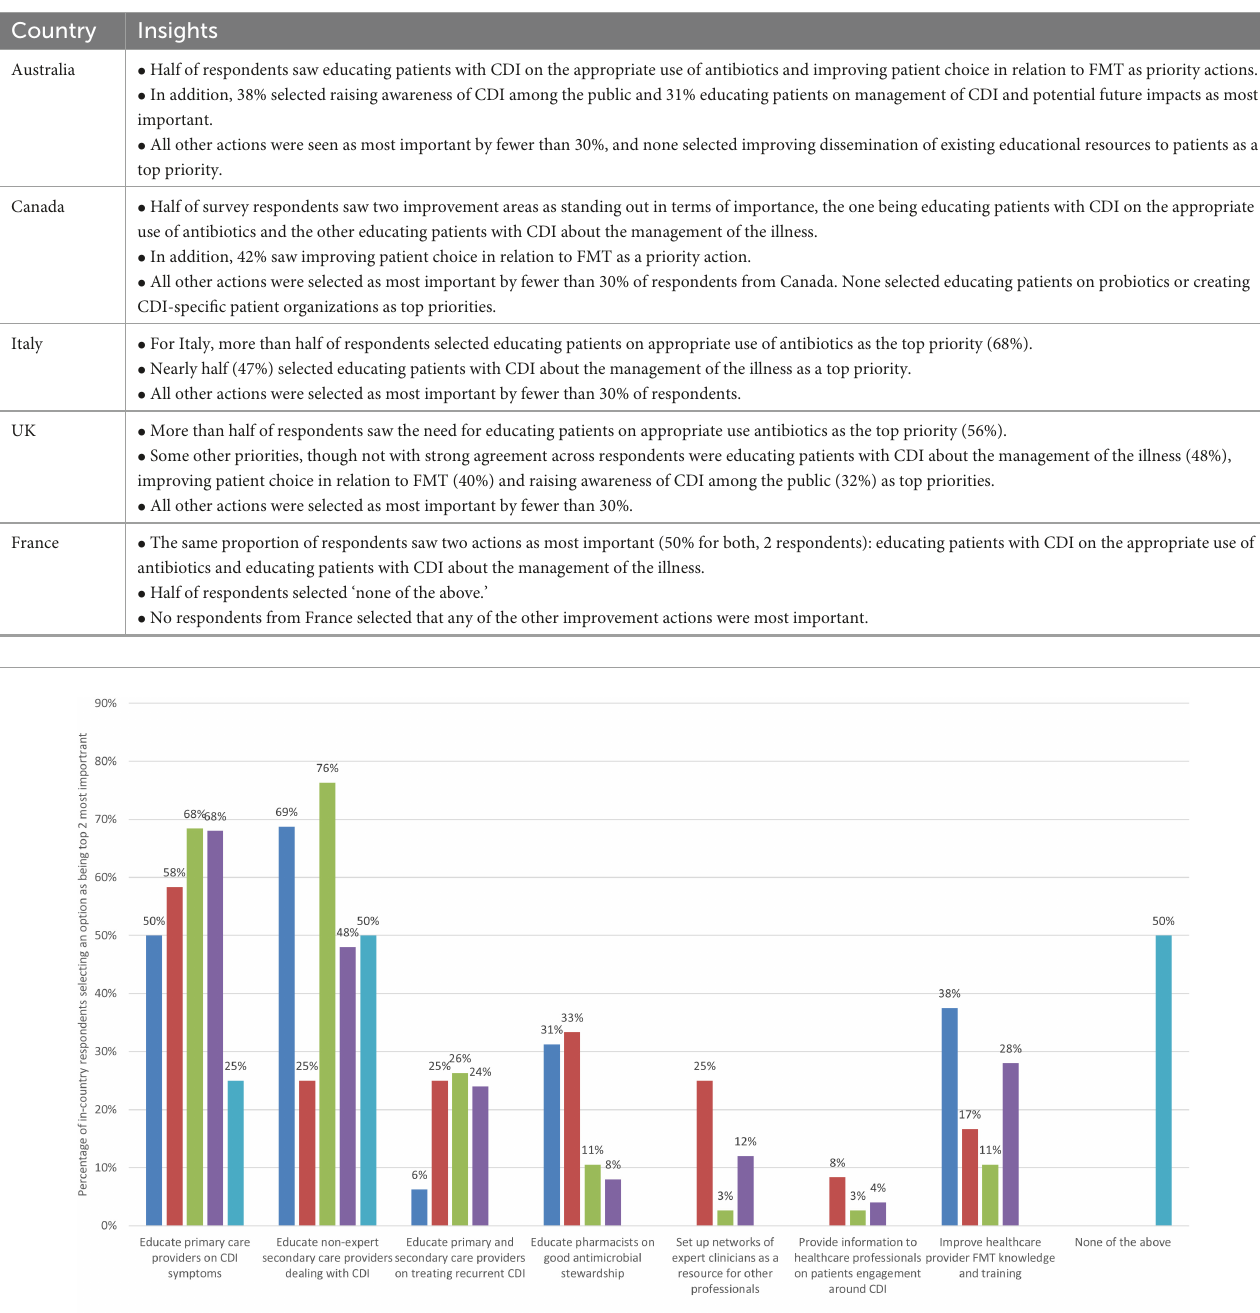
TABLE 7 Country-level insights relating to education and awareness raising for patients priorities. Country Insights